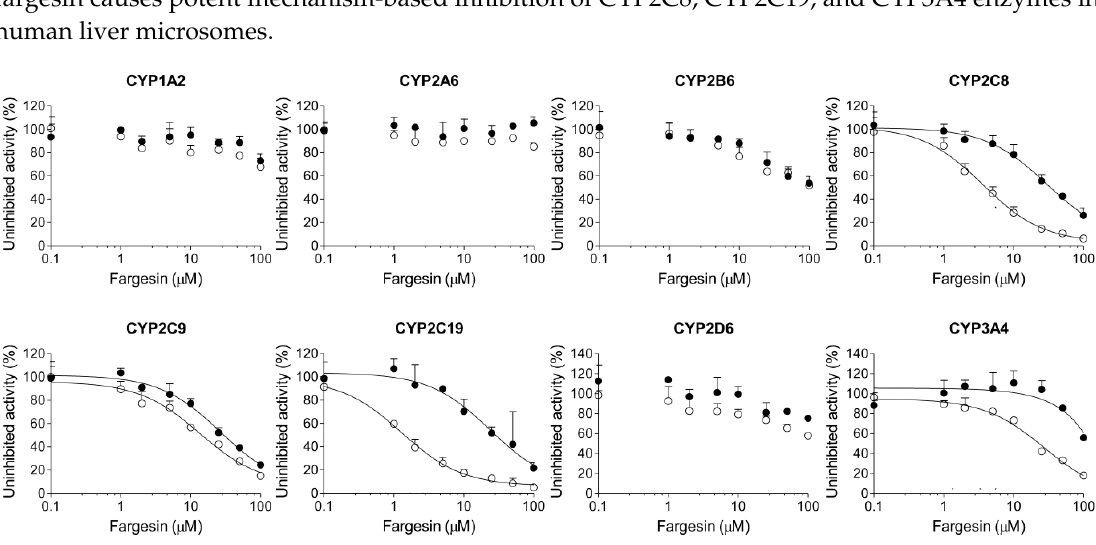
Figure 6. Inhibitory effects of fargesin on CYP1A2-mediated phenacetin O -deethylation, CYP2A6-mediated coumarin 7-hydroxylation, CYP2B6-mediated bupropion hydroxylation, CYP2C8-mediated amodiaquine N -deethylation, CYP2C9-mediated diclofenac 4’-hydroxylation, CYP2C19-mediated [ S ]-mephenytoin 4’-hydroxylation, CYP2D6-mediated bufuralol